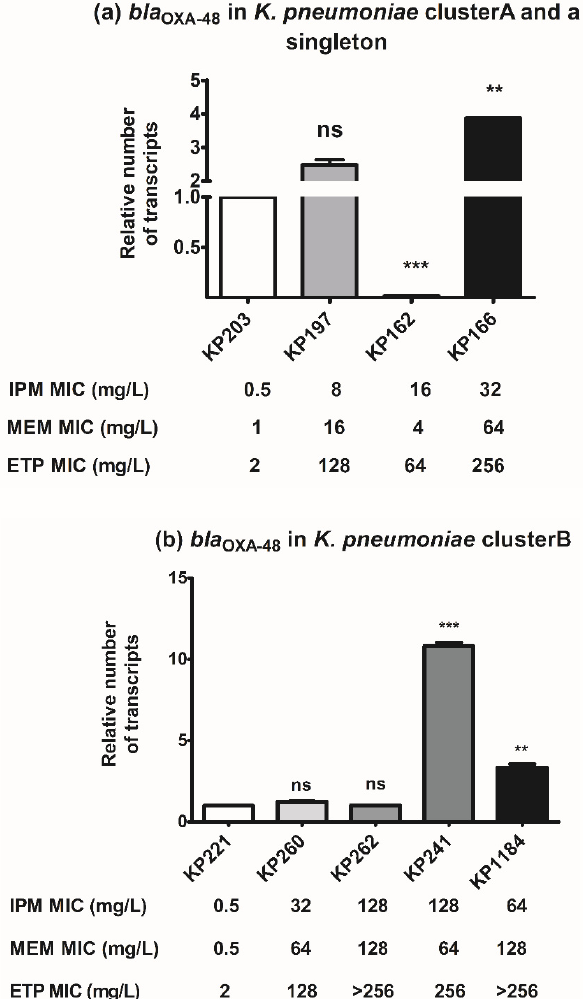
Figure 2. Relative bla OXA-48 expression levels of K. pneumoniae . RT-qPCR assay of bla OXA-48 expression was performed in K. pneumoniae cluster A ( a ), a singleton isolate KP162 ( a ), and cluster B ( b ). The relative number of bla OXA-48 transcripts of K. pneumoniae isolates was normalized to 16S rRNA expression and calculated using the 2 − ΔΔ ct method compared to the expression of imipenem-susceptible K. pneumoniae isolates KP203 and KP221. p -values were calculated using unpaired t -test ( **, p -value < 0.01; ***, p -value < 0.001 and ns, non-significant).